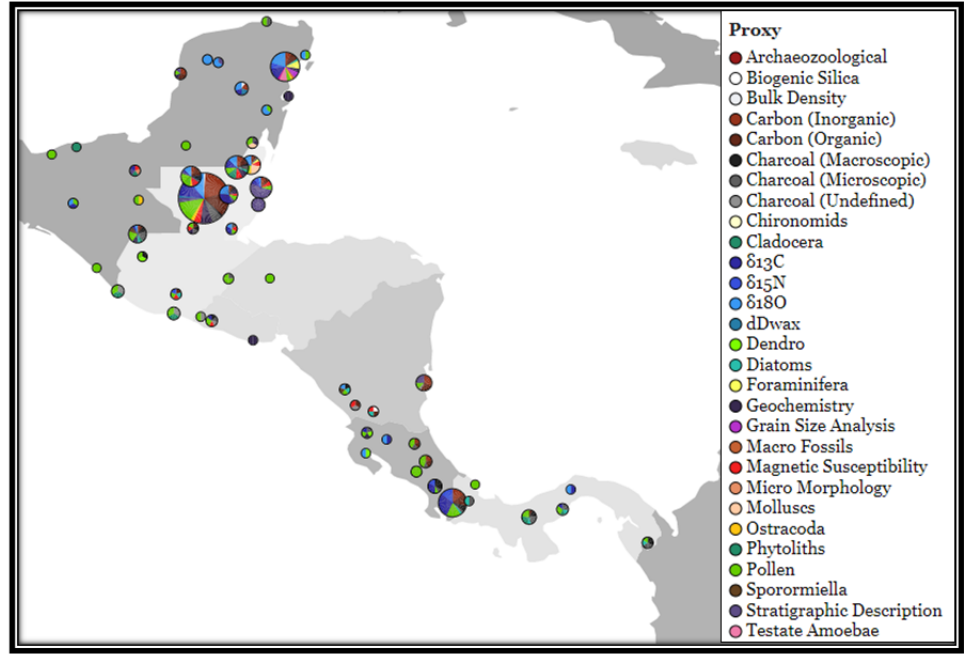
Figure 10. Location and number of studies presenting proxy evidence for: forests, water, and land use change: https://oxsrev.github.io/evidencemaps/palaeo_2021/ (accessed on 26 April 2018).